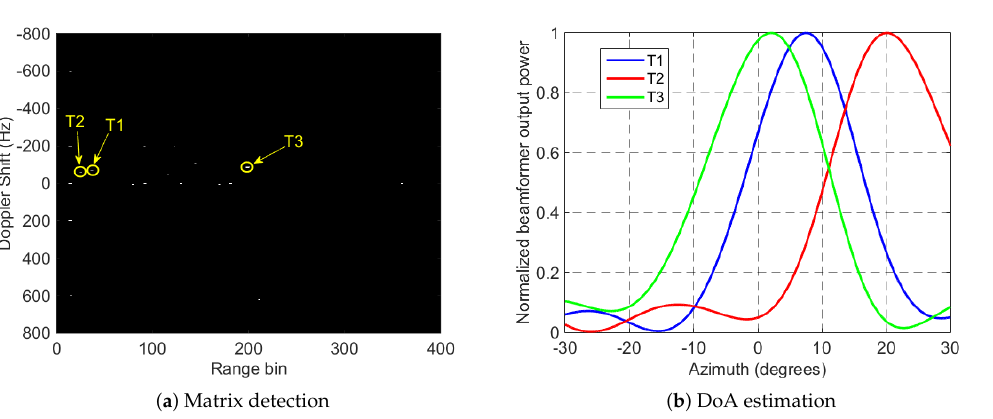
Figure 22. DoA based on the beamformer output spectrum for detections in the 30th CPI associated with the considered trajectories.